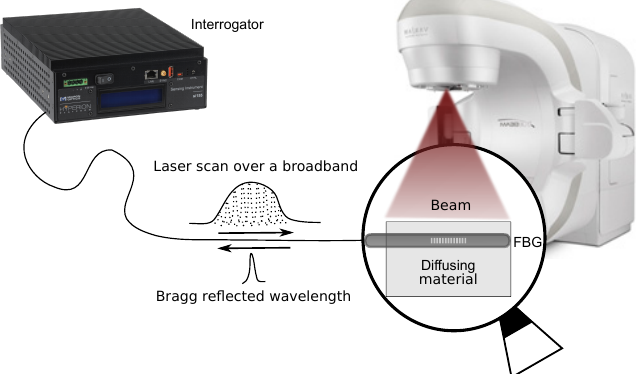
Figure 3. Scheme of the experimental setup. The interrogator produces the input spectrum and measures the FBG reflected spectrum, which here correspond to the signal of interest. The FBG (detector) is placed in solid water under a 6 MV clinical photon